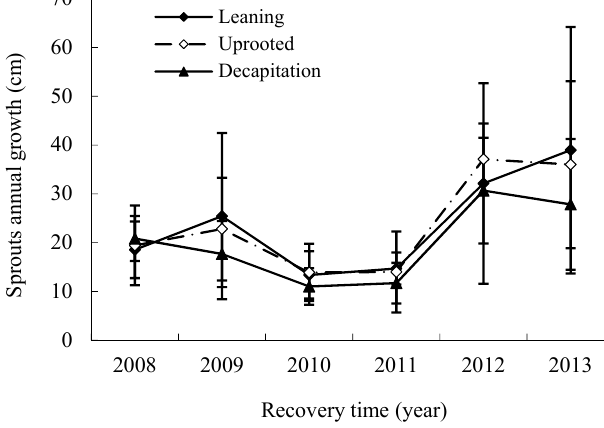
Figure 5. The annual change of sprouts new growth for three damaged types of trees.